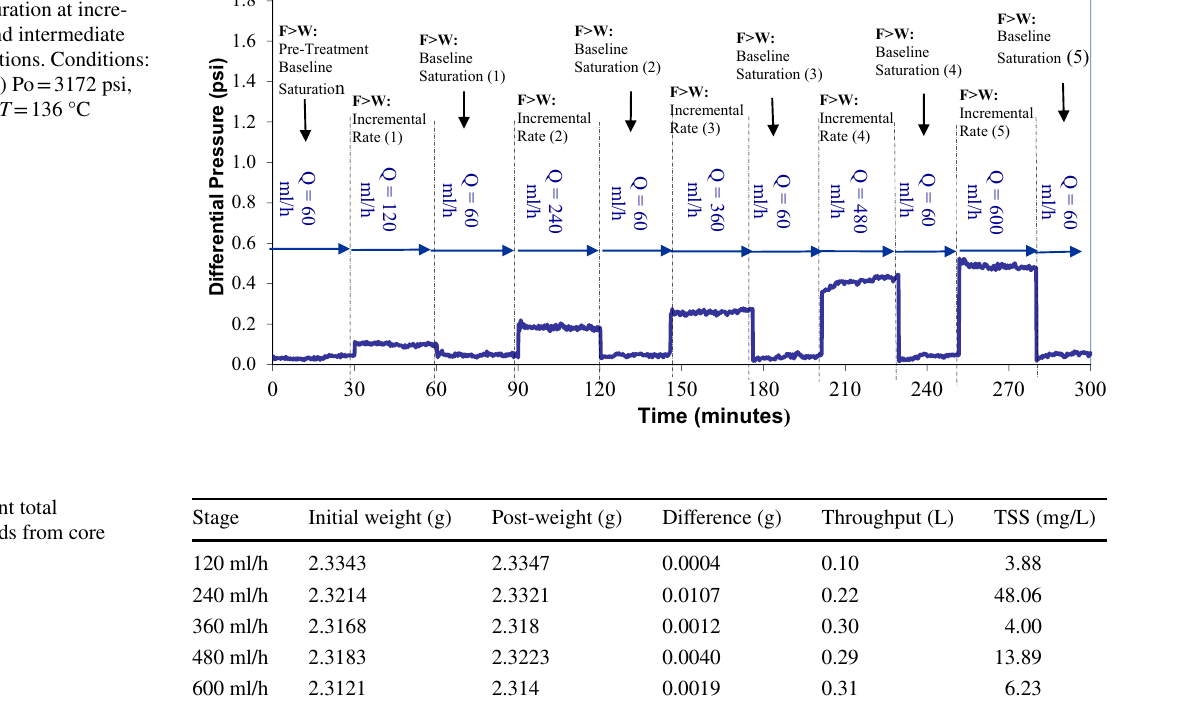
Fig. 6 Differential pressure versus time profile recorded during gas saturation at incre- mental rates and intermediate baseline saturations.